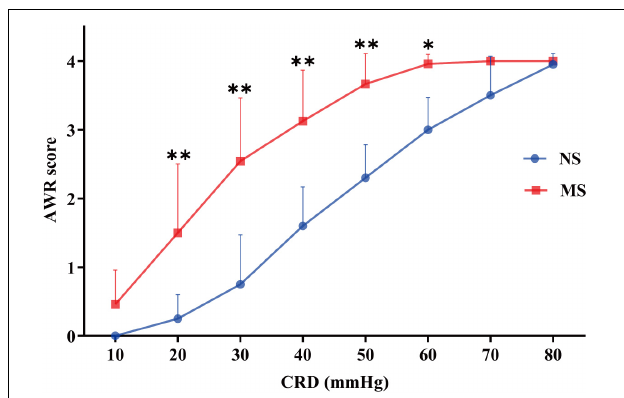
FIGURE 6 | AWR score at different pressures of CRD in MS and NS. The ARW scores at 20, 30, 40, 50, and 60 mmHg were significantly higher in MS compared with NS, respectively. However, there was no difference of AWR score at 10, 70, and 80 mmHg pressure of CRD between MS and NS ( P > 0.05). CRD, colorectal distention; AWR, abdominal withdrawal reflex; MS, maternal separation; NS, non-separation, ∗ P < 0.001, ∗∗ P < 0.0001. MS, n = 12, NS, n =